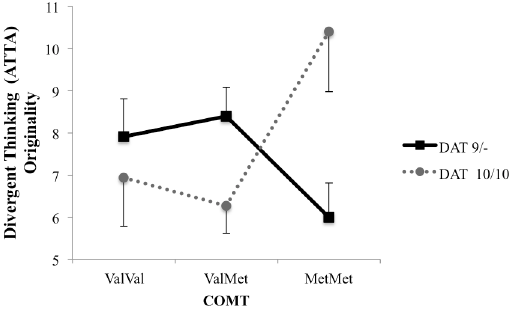
Fig 4. Estimated marginal means for ATTA originality scores, controlling for academic achievement.